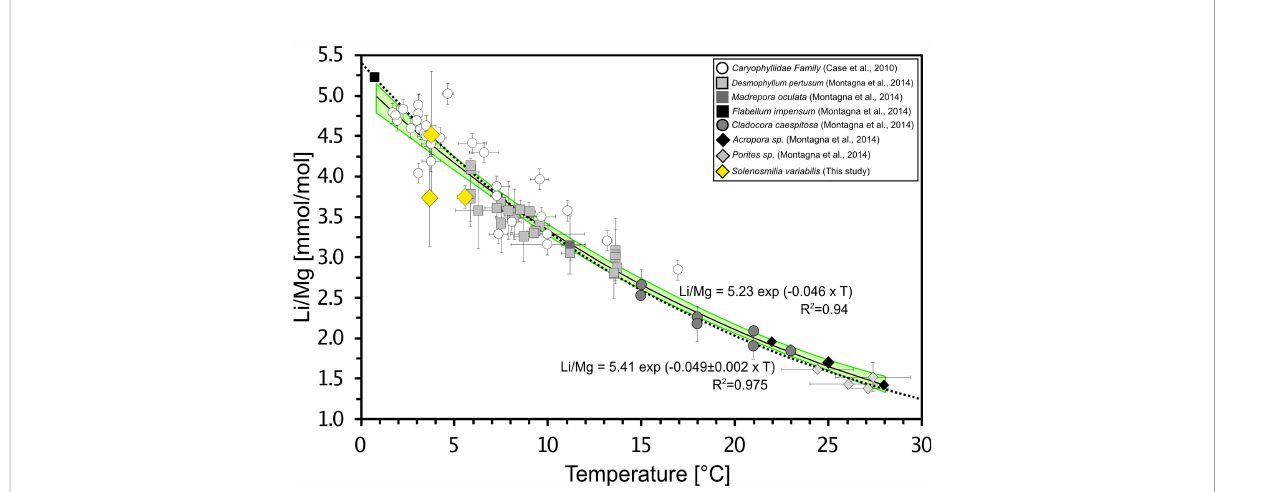
FIGURE 3 Li/Mg. ratio vs. seawater temperature for the published data Case et al. (2010); Montagna et al. (2014) and new data from current study (yellow diamond). The temperature range of cold-water, temperate, and warm-water corals is 0-30°C with a range of the Li/Mg of 1-5.5 mmol/mol measured by laser and solution ICP-MS. The additional measurements are 2.74 ± 0.14 mmol/mol (2SD) at 5.4 ± 0.2°C, 4.52 ± 0.78 mmol/mol at 3.8 ± 0.1°C and 3.74 ± 0.61 mmol/mol at 3.7 ± 0.2°C. The calibration of Montagna et al. (2014) is shown as black dashed line (R2 = 0.975). The black solid line indicates the new function with additional data of this study (R2 = 0.94). Light green shaded band show the 95% con fi dence